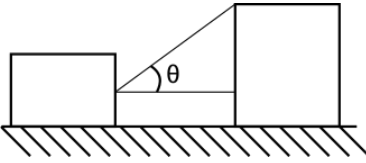
Figure 3. IES VE models generated for different view angles ( a ) 0°, ( b ) 30°, ( c ) 60°. Table 4. View angles (°) and orientations analyzed for each location.